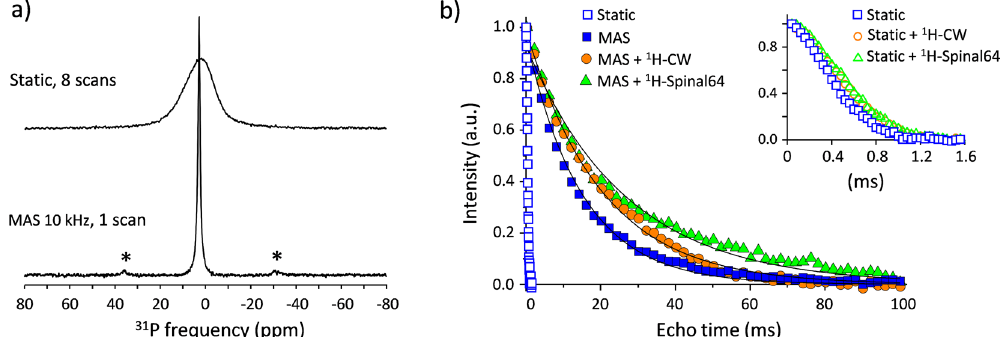
Figure 1. ( a ) 31 P NMR spectra of the CDA phantom recorded at 17.6 T without (top, 8 scans) and with MAS (bottom, one scan) at a spinning frequency of 10 kHz. The asterisks indicate spinning sidebands. ( b ) 31 P spin- echo decay curves of the CDA phantom without MAS (open blue squares) and with MAS (filled blue squares) at a spinning frequency of 10 kHz. The MAS spin echo decay curves obtained applying 1 H CW or 1 H SPINAL64 decoupling ( 1 H RF-field strength of 100 kHz) during the echo time are shown as filled orange circles and filled green triangles, respectively. The black lines correspond to best fits of experimental data with single exponential decay functions. The corresponding T 2 ’ values are 15, 20 and 26.7 ms, without 1 H decoupling, with CW and with SPINAL64 decoupling, respectively. The insert shows a zoom of the 31 P spin echo decay under static conditions without 1 H decoupling (open blue squares), and with CW (open orange circles) or SPINAL64 decoupling (open green